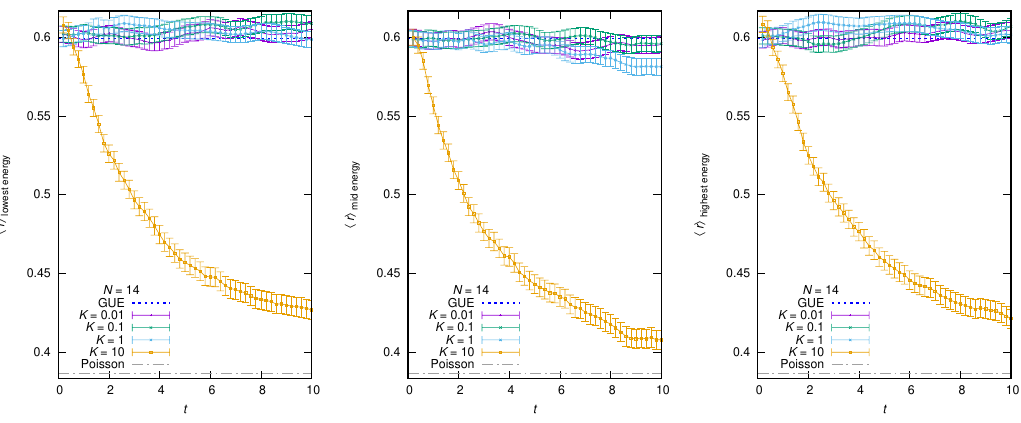
Figure 18 . The r -parameter h r i with (cid:12)xed- i unfolding, obtained using all exponents for the N site = 14 SYK model, for the ground state (left), the state at the center of the energy spectrum (center) and the highest energy state, plotted as a function of t for K = 0 : 01 ; 0 : 1 ; 1 ;